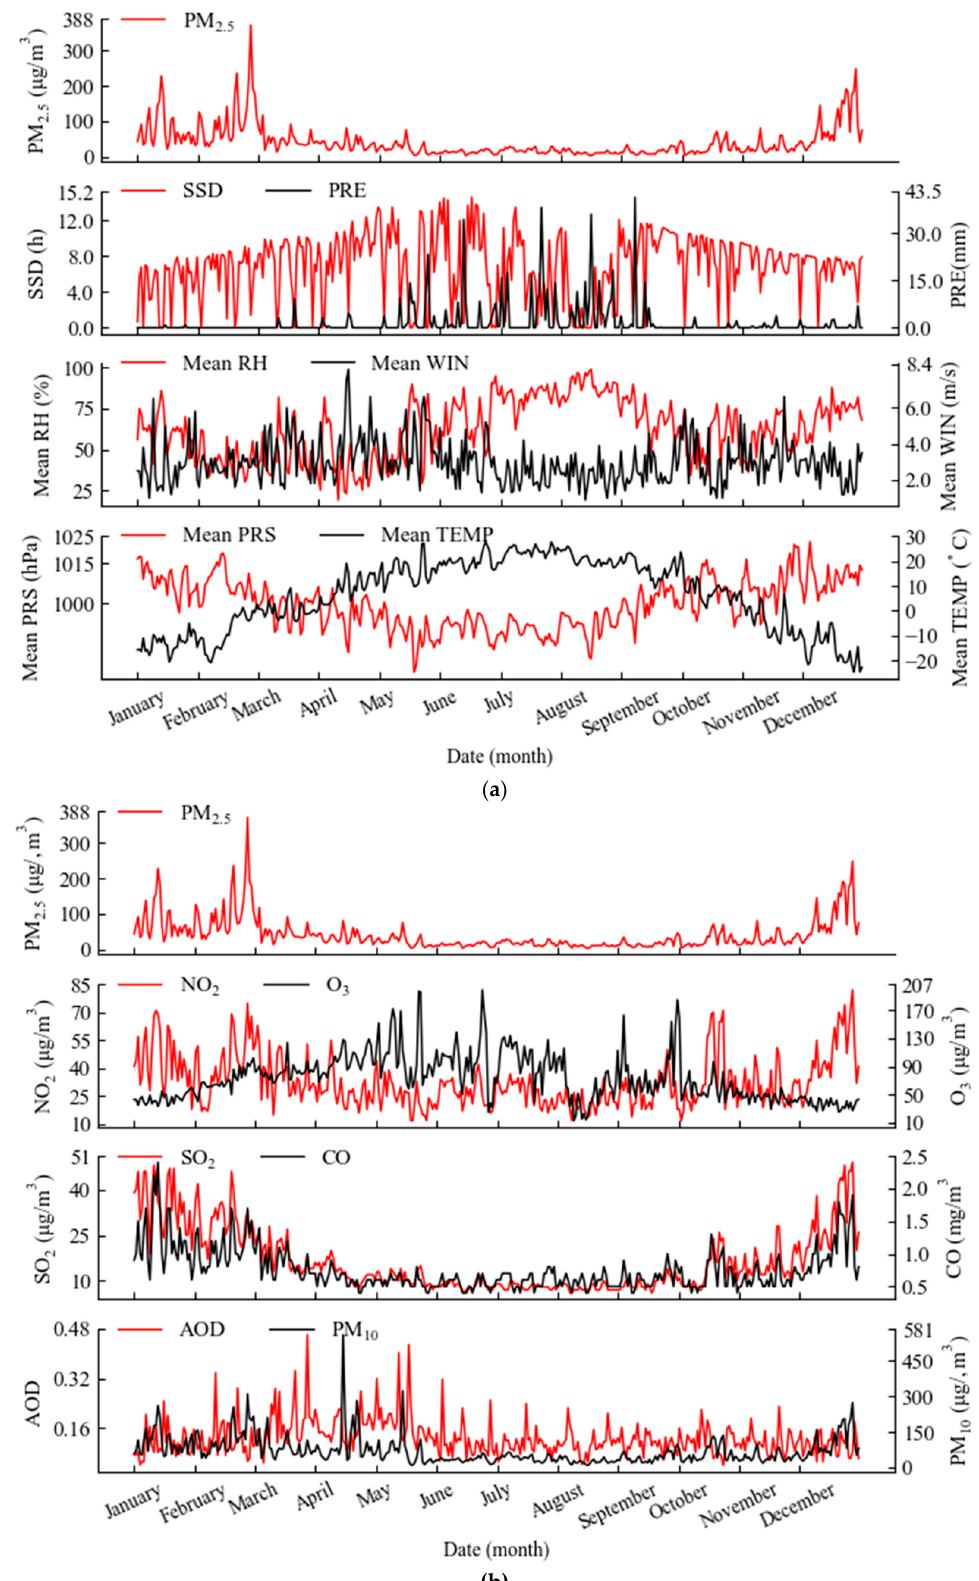
Figure 9. Changes of the PM 2.5 concentration, air pollutants, and meteorological conditions in 2019. ( a ) Concentrations of PM 2.5 and meteorological conditions. ( b ) Concentrations of PM 2.5 and air pol ‐ lutants.